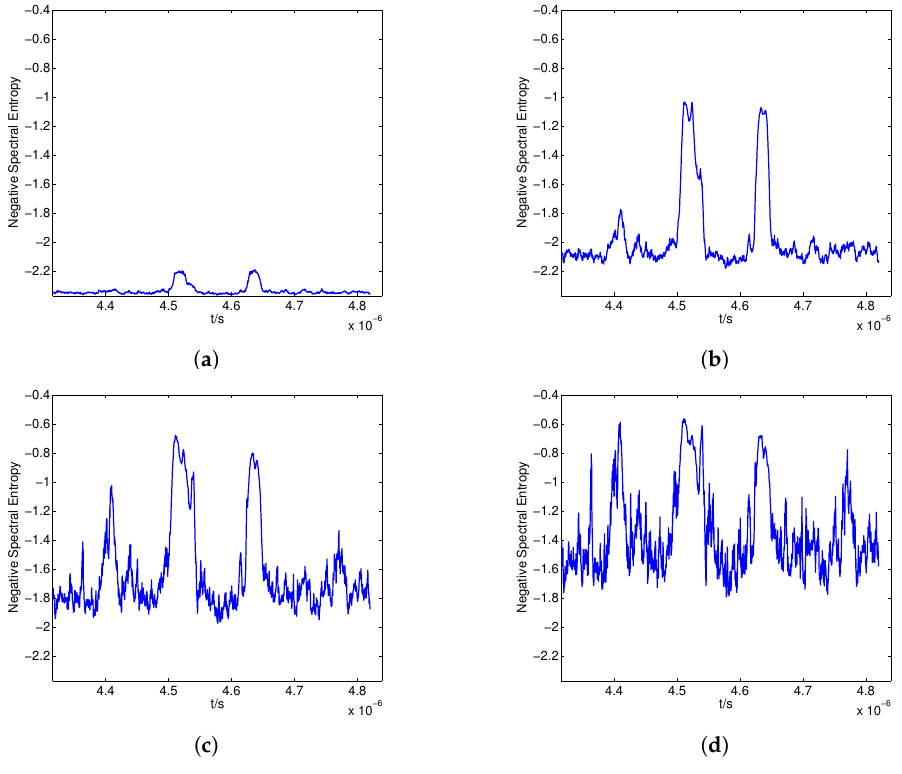
Figure 8. Negative spectral entropy for γ = 1 ( a ); γ = 3 ( b ); γ = 5 ( c ); γ = 7 ( d